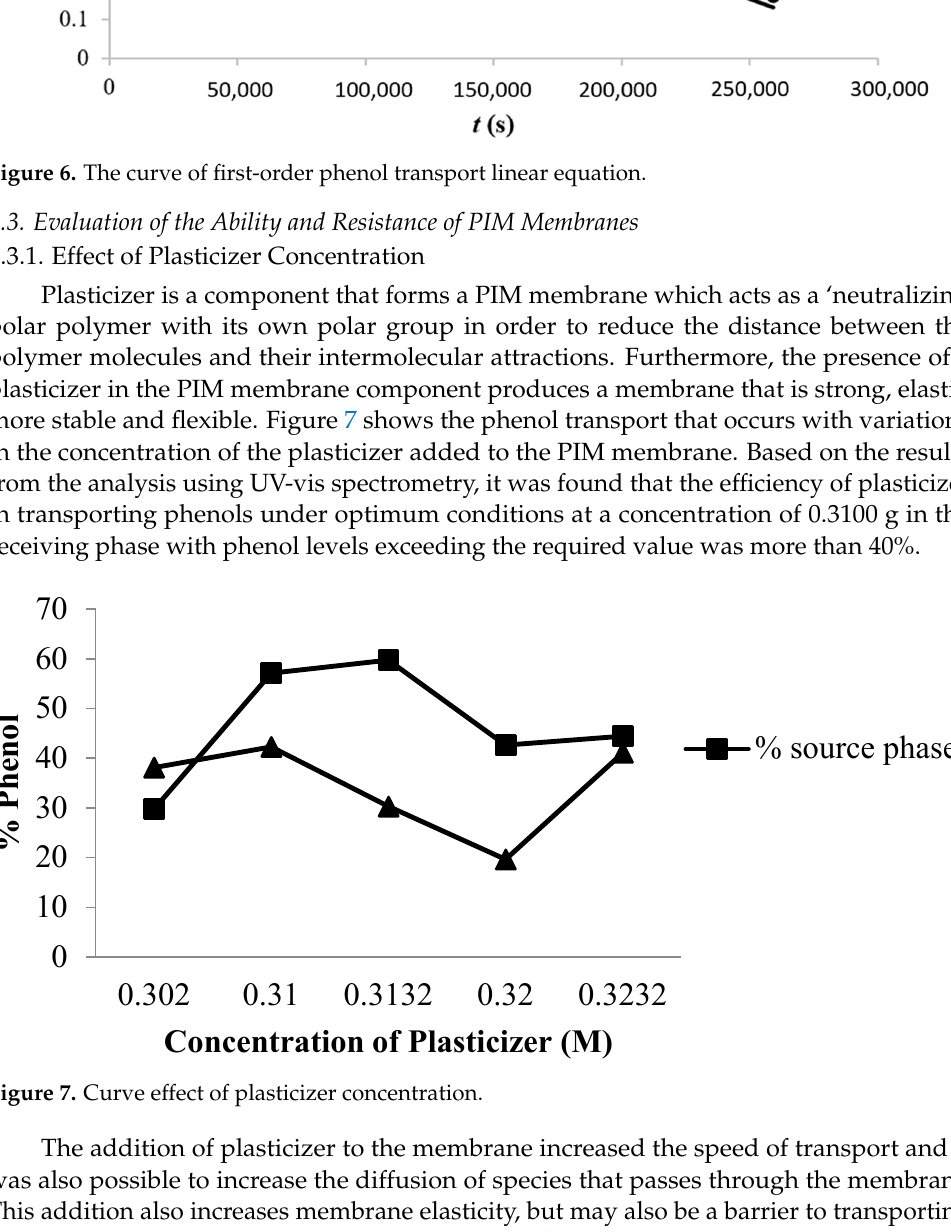
Figure 6. The curve of first-order phenol transport linear equation. Table 2. Values of first order and second order equations based on time variations .